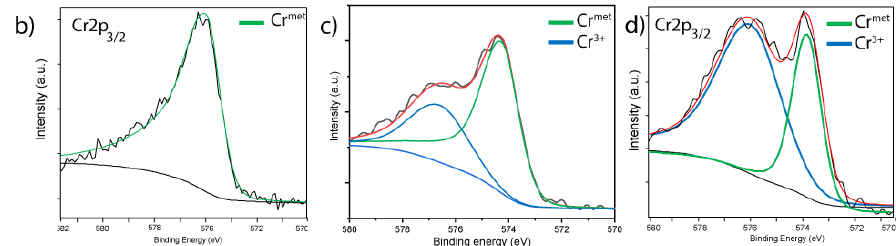
Figure 7. A comparison of XPS ( a ) survey spectra of virgin powder with spatters and condensate deposited on heat shield along with fitted narrow scans of ( b ) virgin powder, ( c ) spatter particles, and ( d ) condensate at 30 nm etch depth.